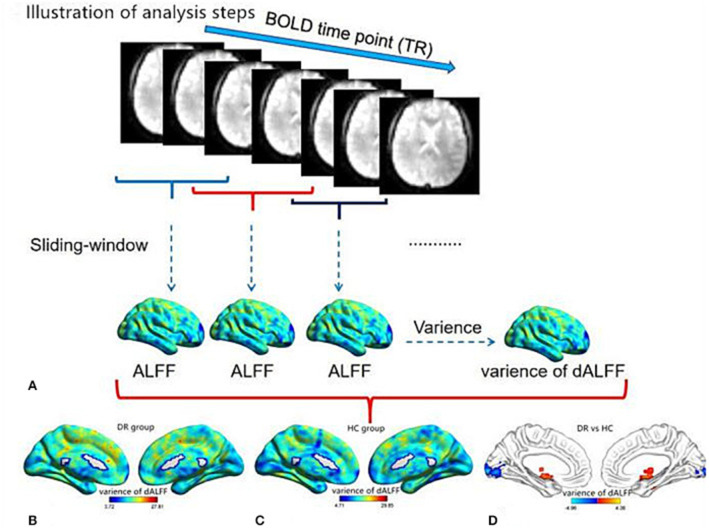
Illustration of analysis steps and temporal variability of dALFF pattern. (A) The pre-processed full-length BOLD fMRI time series was segmented into several sliding windows (50TRs). The temporal variability of the dALFF was defined as the variance of dALFF maps across the sliding windows. The pattern of temporal variability of the dALFF in the DR group (B) and HC group (C). The different temporal variability of dALFF between two groups. (D) dALFF, dynamic amplitude of low-frequency fluctuation; DR, Diabetic Retinopathy; HC, Health Controls.